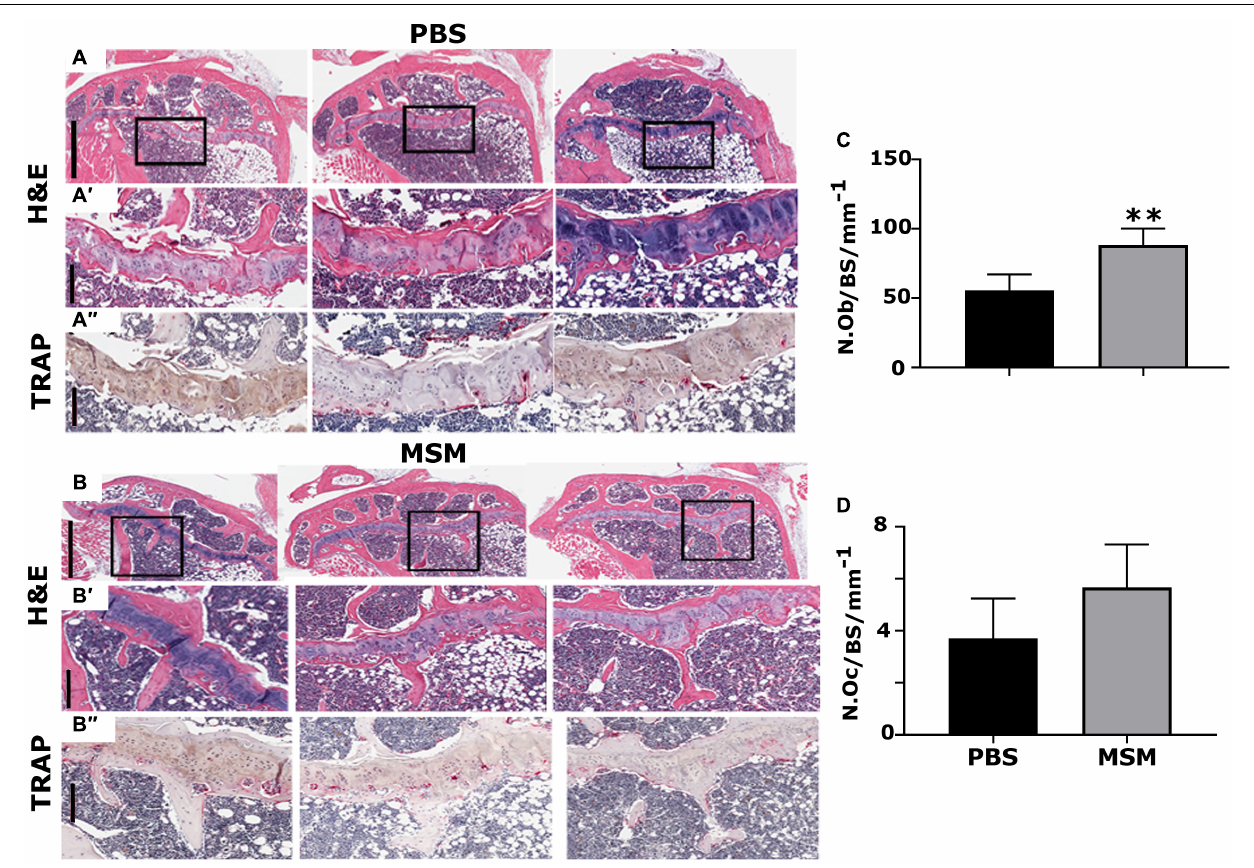
FIGURE 4 | Histological assessment of the proximal right tibial bone sections in mice injected with PBS (A) and MSM (B) for 13 weeks. (A,A (cid:48) ,B,B (cid:48) ) Hematoxylin and Eosin (H&E) stained and (A (cid:48)(cid:48) ,B (cid:48)(cid:48) ) TRAP-stained proximal right tibial sections are shown in triplicate for each injection. Black squares in panels (A,B) indicate the region enlarged in panels (A (cid:48) ,B (cid:48) ) . The same area of the magnified bone section stained for TRAP is shown in panels (A (cid:48)(cid:48) ,B (cid:48)(cid:48) ) . Dark purple-stained cells seen attached to the bone surface are TRAP-positive osteoclasts [panels in (A (cid:48)(cid:48) ,B (cid:48)(cid:48) ) ]. Scale bars represent 800 µ m in panels (A,B) ; 200 µ m in the magnified H&E (A (cid:48) ,B (cid:48) ) and TRAP- (A (cid:48) ,B (cid:48) ) stained panels. Quantification of the number of osteoblasts (N. Ob) and osteoclasts (N. Oc) was performed in the tibial metaphyseal bone surface (BS) region. Quantification was performed using the Fiji (ImageJ) software, and the results are shown as the mean ± SEM of six mice per injection. A standard Student’s t -test was used to analyze p -values. ∗∗ p <